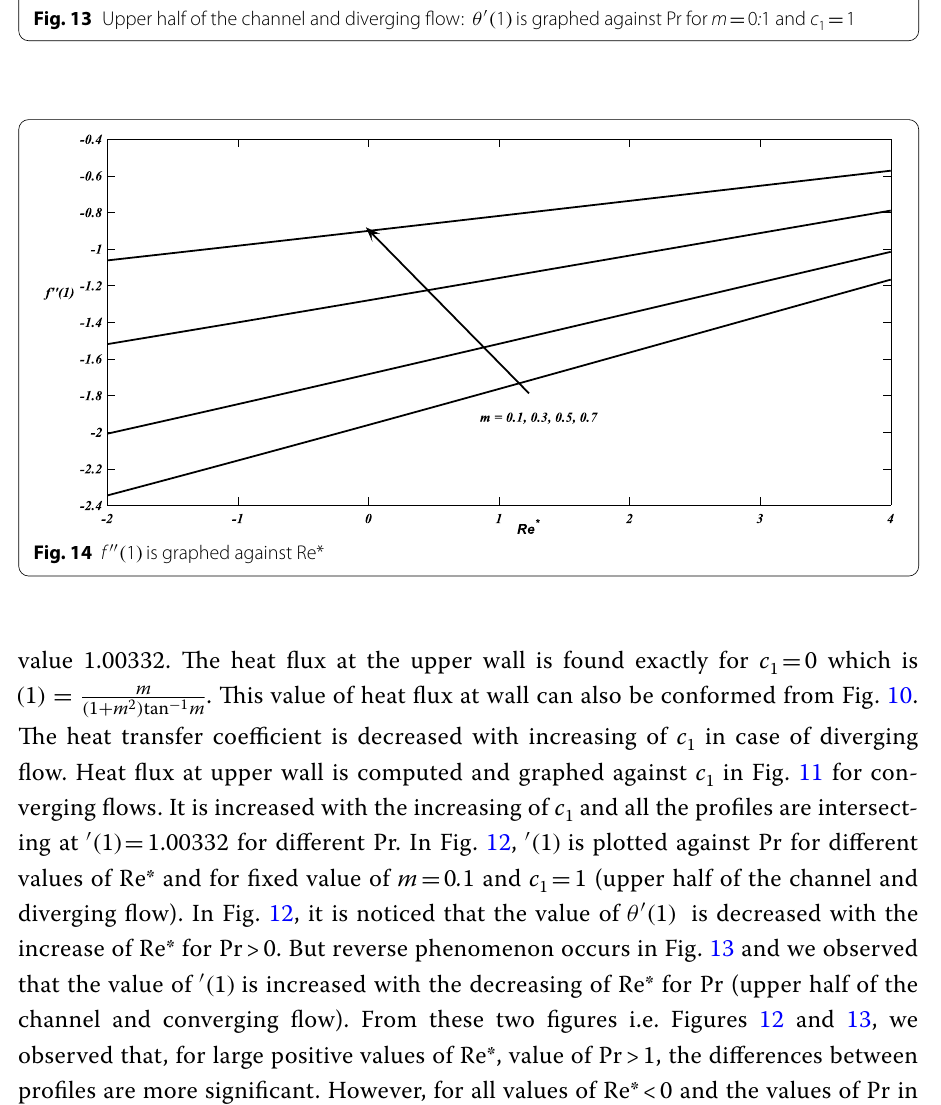
Fig. 13 Upper half of the channel and diverging flow: θ ′ ( 1 ) is graphed against Pr for m